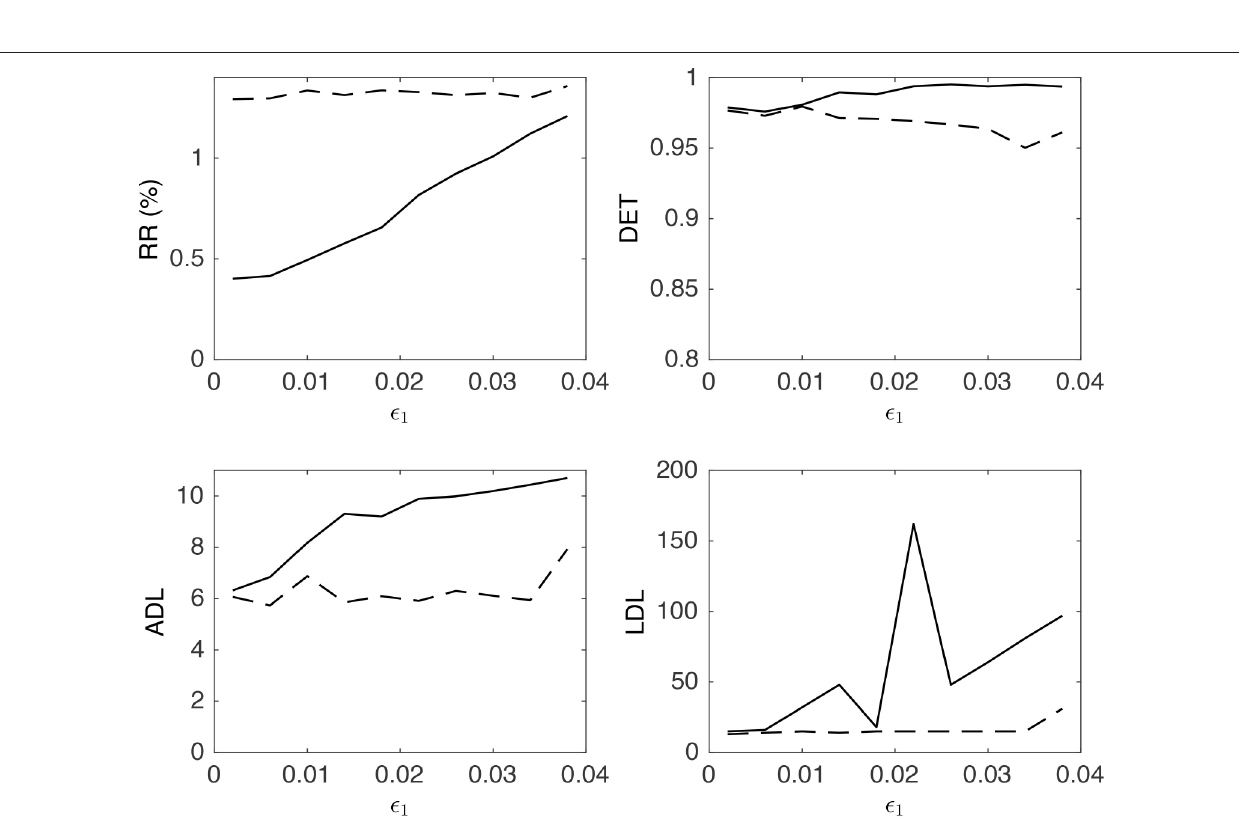
Frontiers in Psychology |